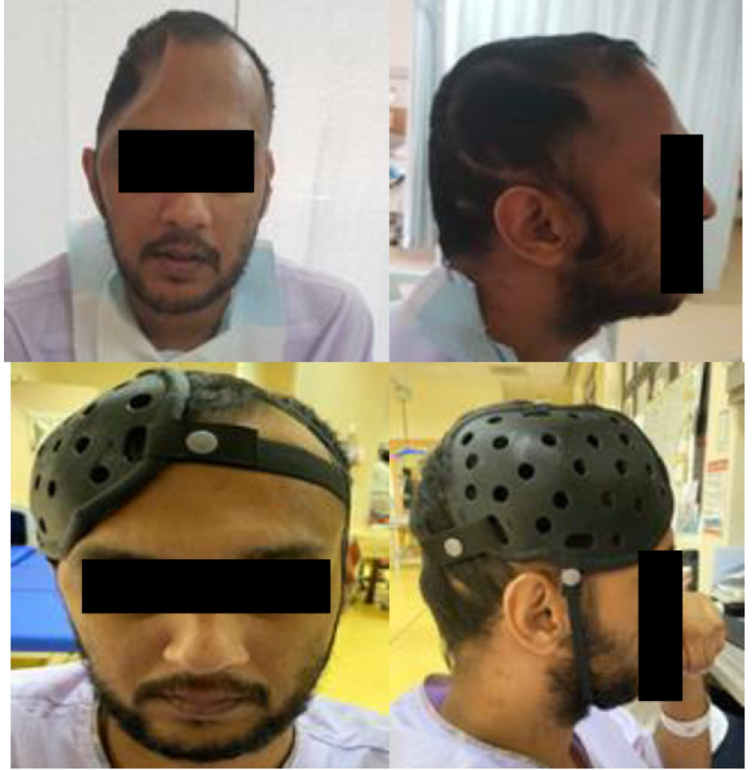
Fig 3. Subject pre and post head protection prototype device (HPPD) fitting showing anterior (left) and right lateral (right) views.